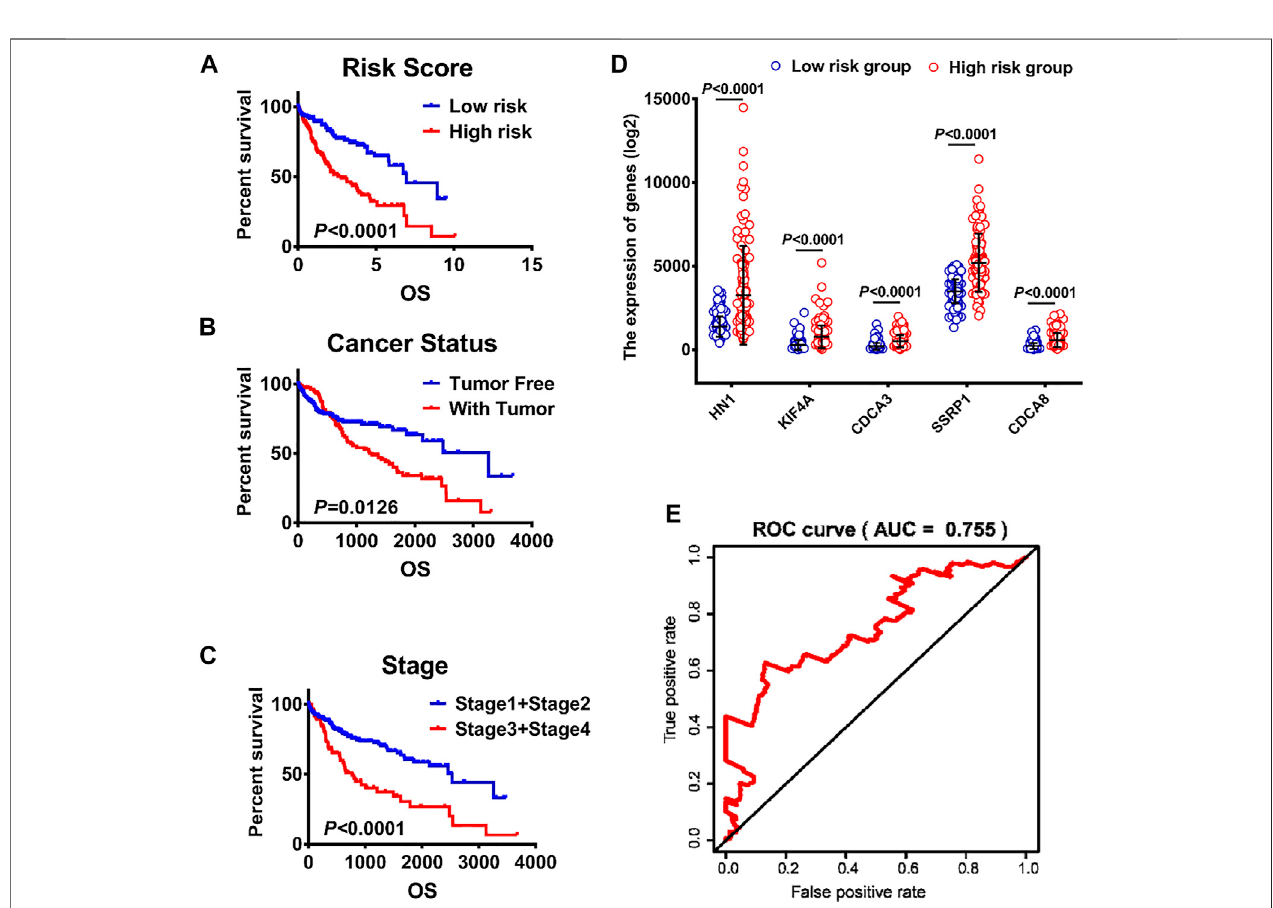
FIGURE 5 | Analysis of clinicopathological parameters affecting the prognosis of hepatocellular carcinoma patients (A) K – M survival curves of patients in high-risk and low-risk groups. (B – C) The effects of different clinicopathological parameters including cancer and stage on patients ’ Kaplan – Meier survival curves (D) The expression levels of HN1, KIF4A, CDCA3, SSRP1 and CDCA8 in low- and high-risk groups. (E) A ROC curve of patients with HCC from TCGA.